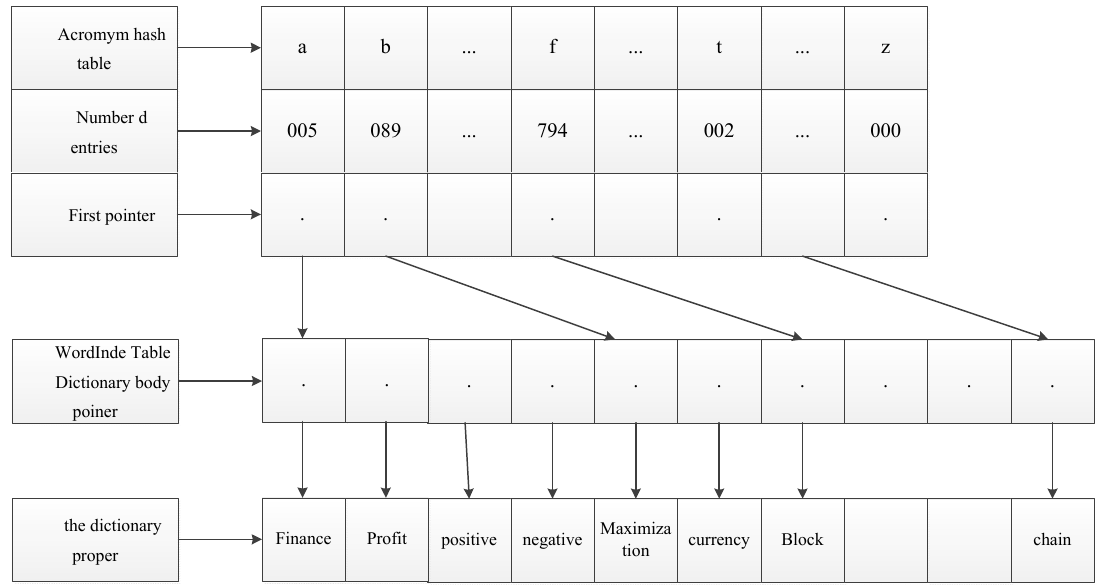
Figure 2. Word segmentation storage mechanism based on binary-seek-by word.